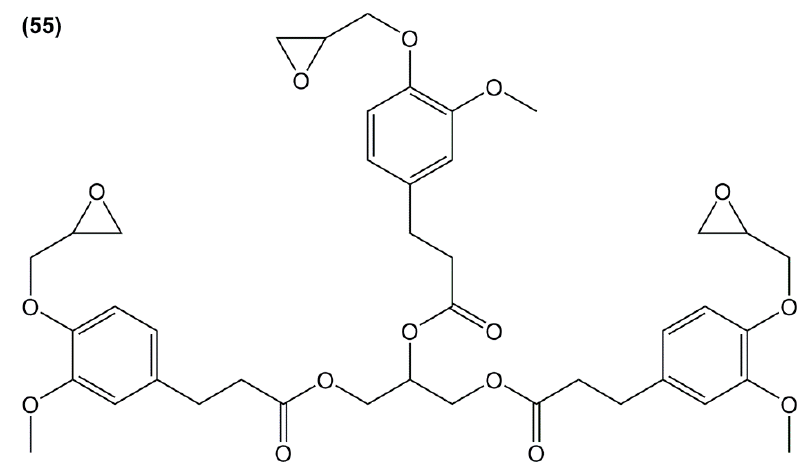
Figure 30. Tri-epoxy monomer based on ferulic acid and glycerol synthesized by Ménard et al. [166].